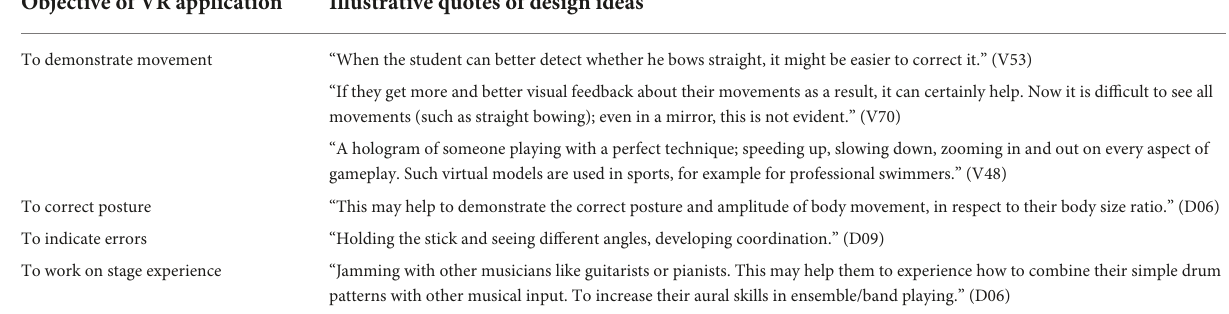
TABLE 4 Teachers’ design ideas for VR